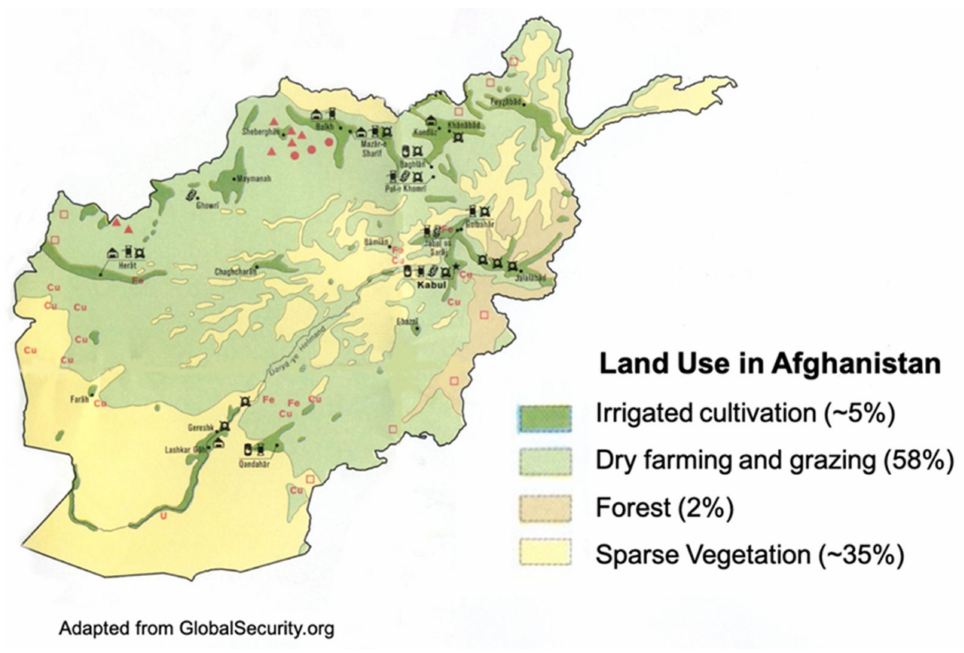
Figure 2. Map of land use in Afghanistan showing sparse vegetation across regions of greatest scatterable mine